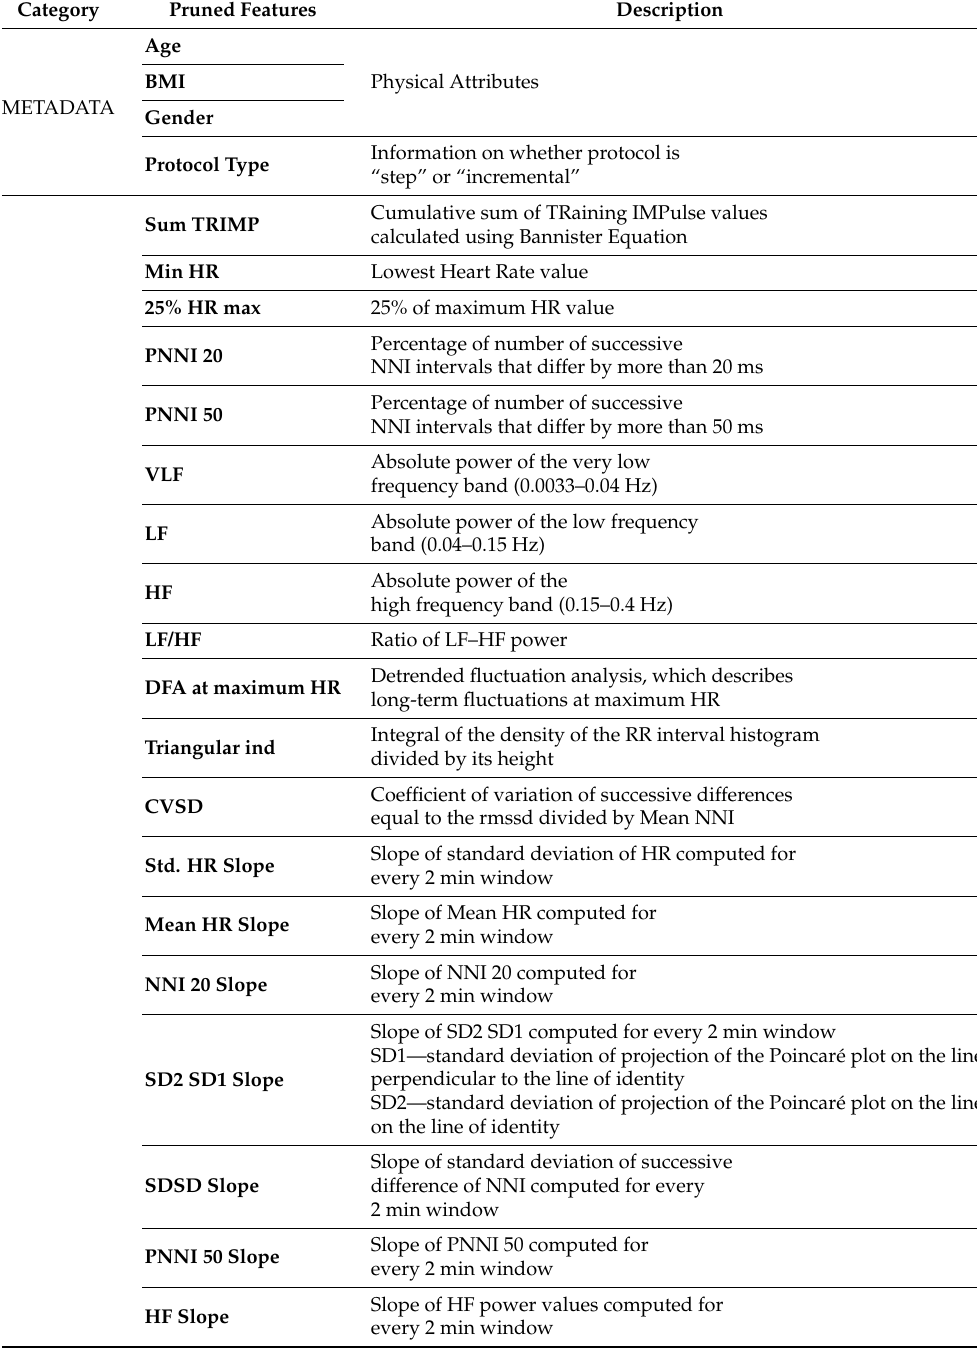
Table A2. Mutual Information–based Pruned Features for exercise